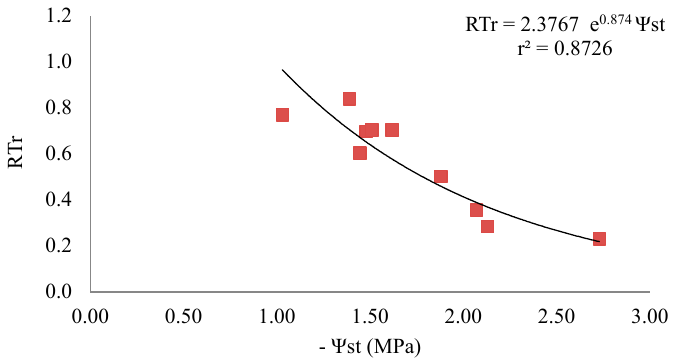
Figure 4. Relationship between Ψ st measured after solar noon and daily relative transpiration (RTr) of plum. Each point is the average of two trees only for the days when Ψ st was measured during the last period of each stress cycle (2014–2016).